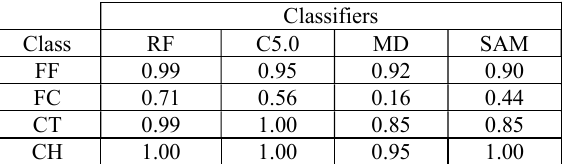
Table 8 . Level of accuracy of the producer.